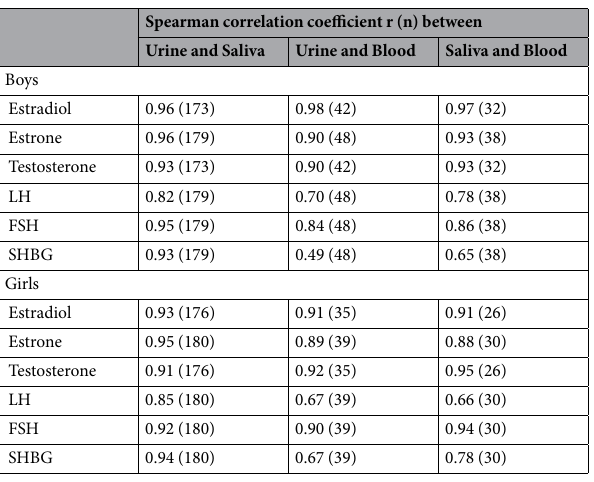
Table 2. Correlations between analyte concentrations in urine, saliva and blood samples.